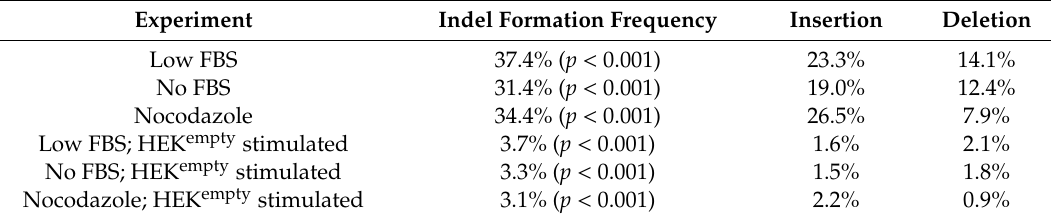
Figure 8. Graphical overview of synNotch-mediated indel formation within the CXCR4 gene based on chromatogram files analyzed using TIDE. Table 5. TIDE analyses of synNotch-mediated gene editing in receiver cells in which the cell cycle was arrested at di ff erent